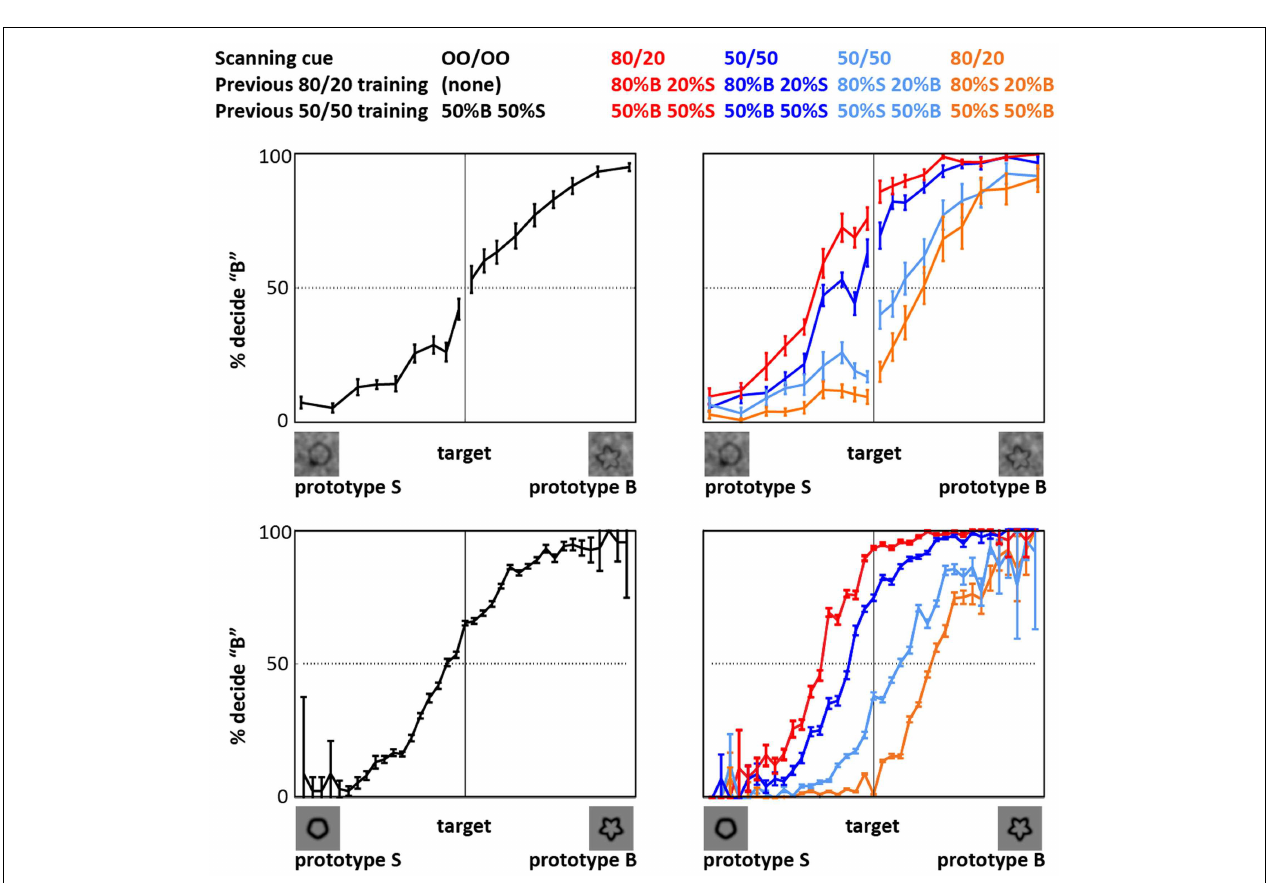
the likelier category to appear was Category S (smoother); behavior given the 80/20 cue. Relative to the other subjects, the decision reports of these subjects are biased in favor of an “S” response. Light blue: behavior of the same subjects given the 50/50 cue. Error bars represent ± 1 SE across subjects. In the categorical uncertainty plots (bottom), the error bars tend to be very small at intermediate and larger at extreme stimulus levels.This pattern reflects the fact that the form-modulated target distribution included many intermediate, i.e., ambiguous, targets, and relatively few extreme, i.e., unambiguous,